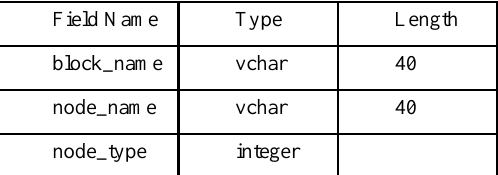
Figure 4. Two types of Split-and-Merge paradigms